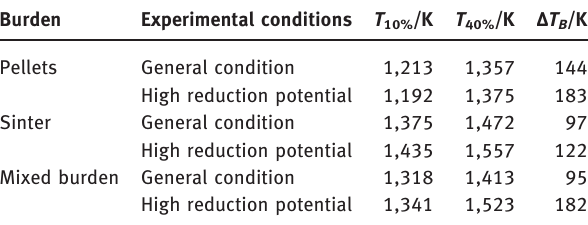
Table 3: The soft characteristic temperature of different burdens in general and high reduction potential.